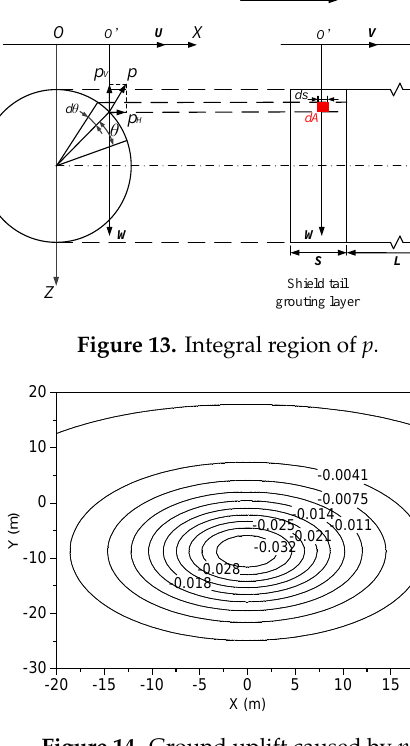
Figure 14. Ground uplift caused by p .